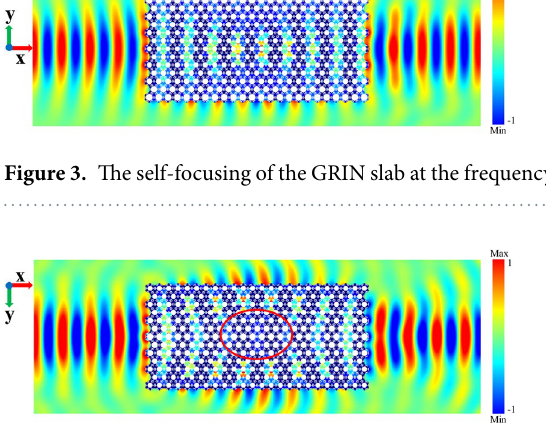
Figure 4. The acoustic wave propagation trajectory in the cloaking